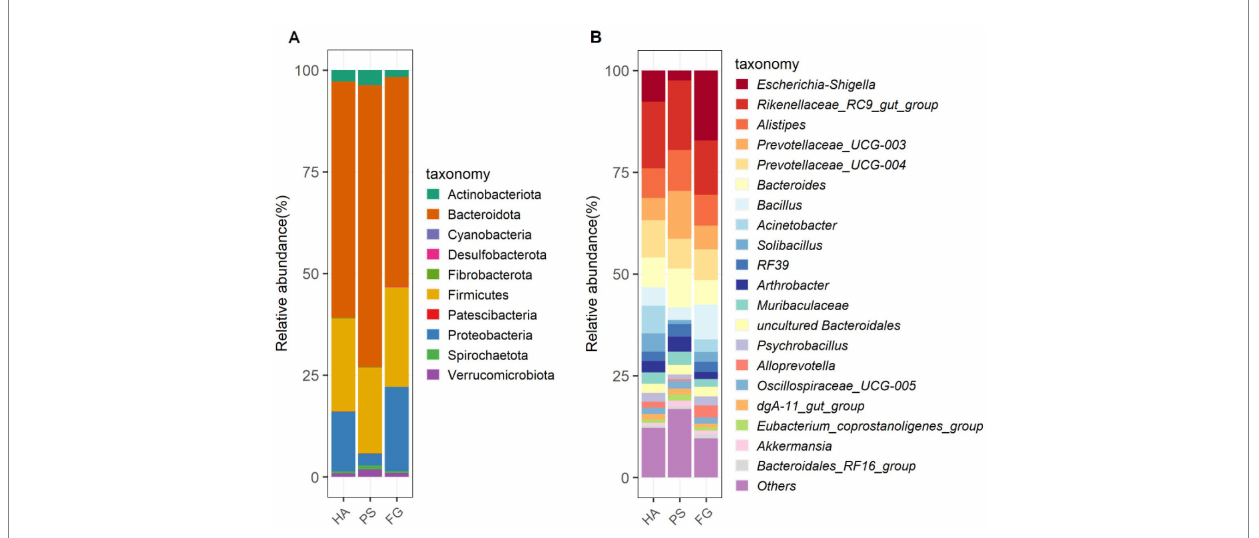
FIGURE 2 The composition and relative abundance of rumen microbial community of goats. Microbial community bar plot of phyla in rumen (A) . Microbial community bar plot of top 20 genera in rumen (B) .